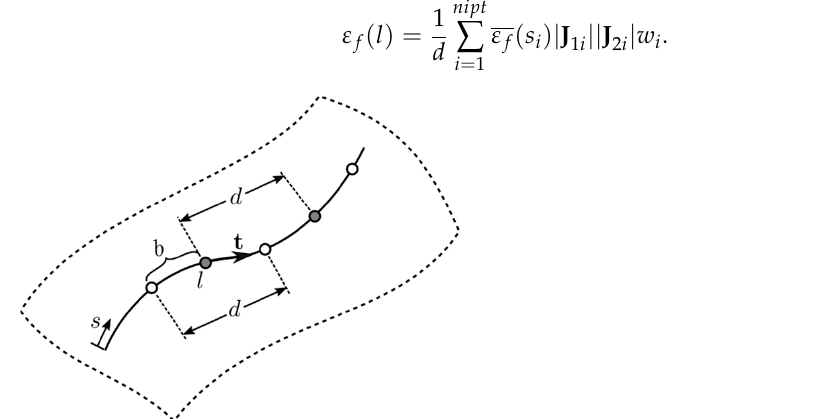
Figure 4. Illustration of fiber strain sampling points (circles) with sampling interval b and sampling resolution d ; sampling resolution is numerically the same as the moving average window.